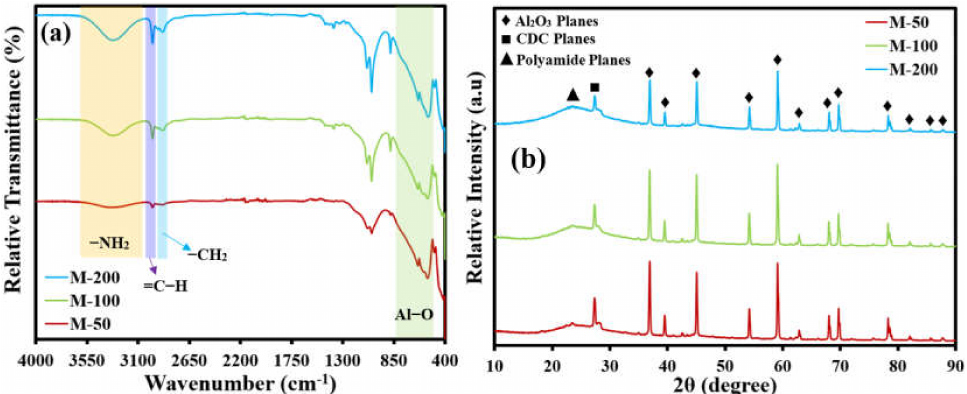
Figure 4. ( a ) FTIR spectra and ( b ) XRD patterns of all of the fabricated